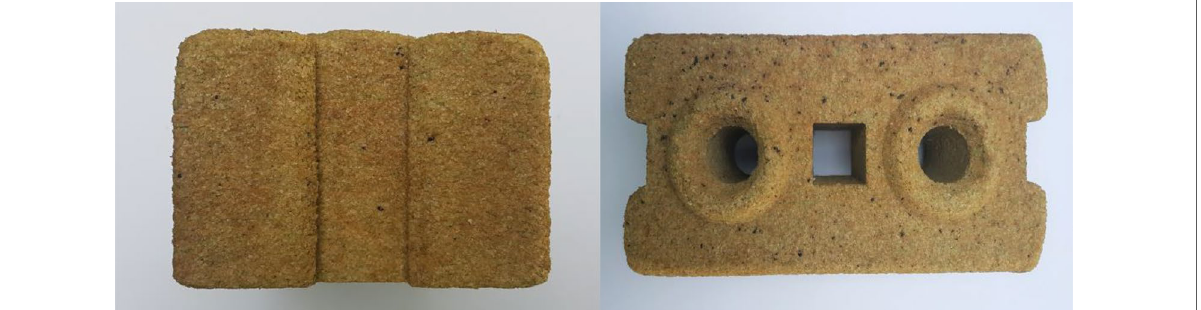
Fig. 2 Interlocking brick (side view and top